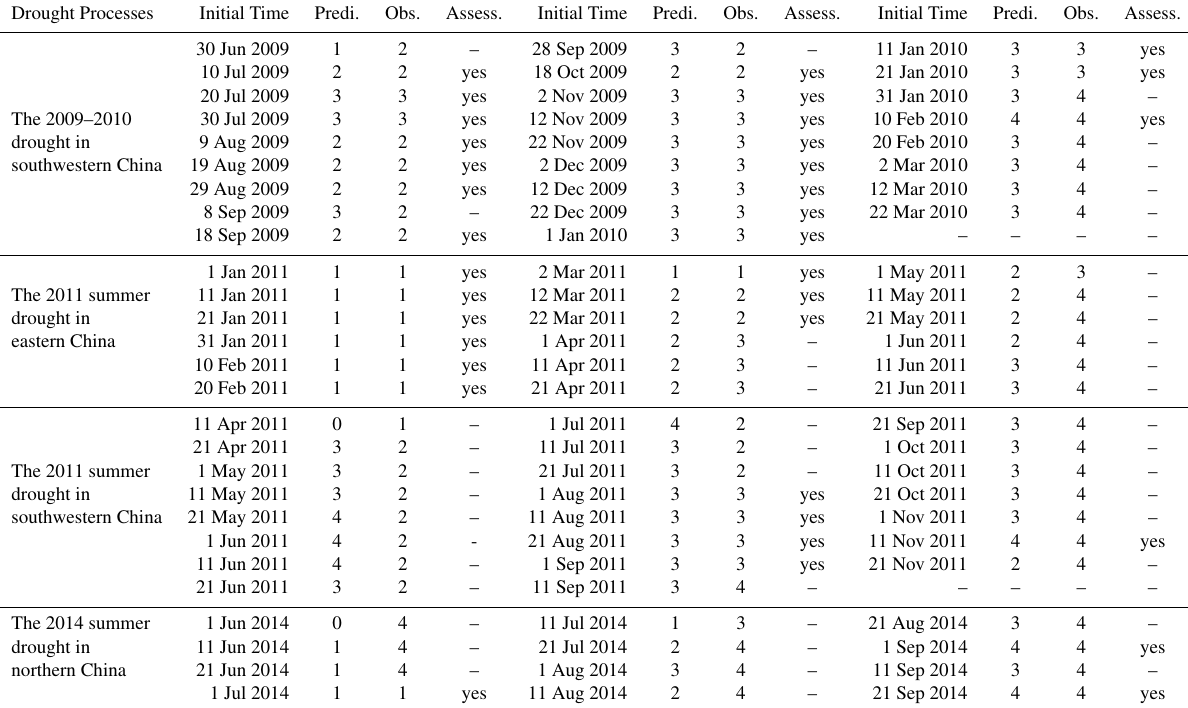
Table 9. Same as Table 8 but for predicted results forced with the operational output from CFSv2. The abbreviation “Predi.” represents the predicted drought outlook. The abbreviation “Assess.” in the column refers to whether the prediction and observation agree or not. Drought Processes Initial